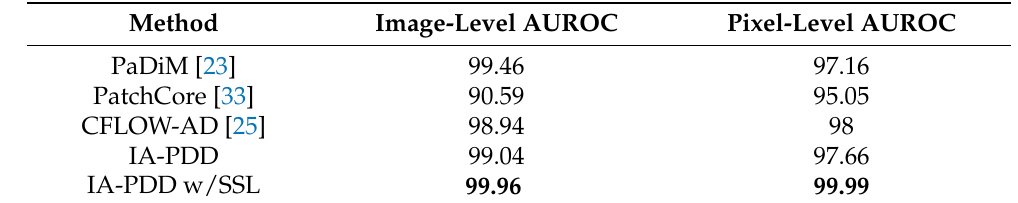
Table 1. Quantitative results for BRACOL [13] dataset at image- and pixel-levels with respect to AUROC, where “w/SSL” means “with self-supervised pretraining of feature extractor”.